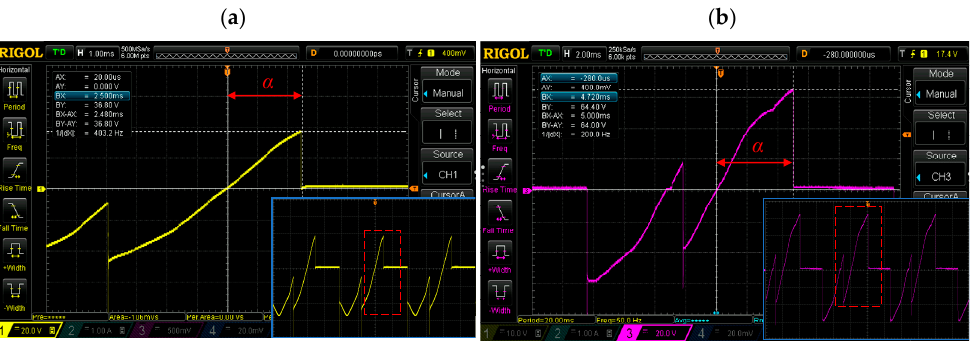
Figure 5. Voltage waveforms of the thyristor for firing angle of 𝛼 = 45° ( a ) and firing angle 𝛼 = 90° ( b ).